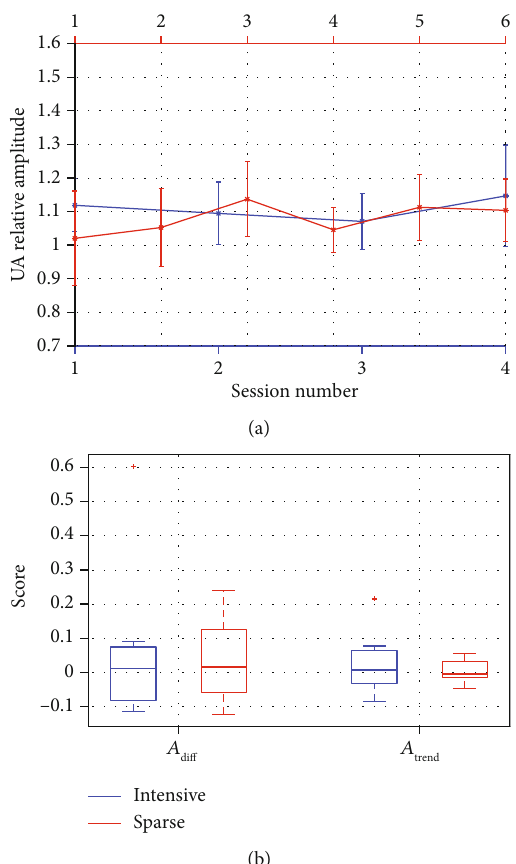
Figure 2: (a) Evolution across sessions for the INTENSIVE (blue) and SPARSE (red) groups during neurofeedback (NF) at Fz: median values of upper alpha (UA) band amplitude; error bars show median absolute deviation. (b) Boxplot with the distribution of A A (equation (3)) measures for the INTENSIVE (blue) and SPARSE (red) groups; + represents trend